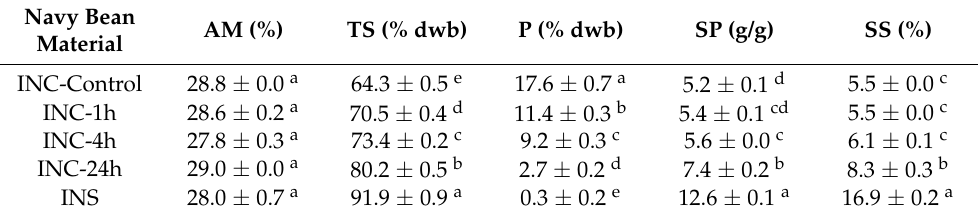
Table 1. Physicochemical properties of INS, control INCs, and INCs pretreated with pepsin for 1, 4, or 24 h. Navy